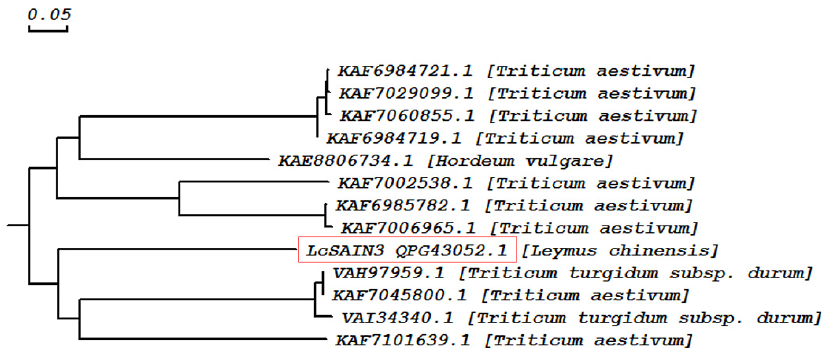
Figure 1. Phylogenetic analysis of LcSAIN3 and homologs was constructed based on amino acid sequences using the neighbor–joining method.